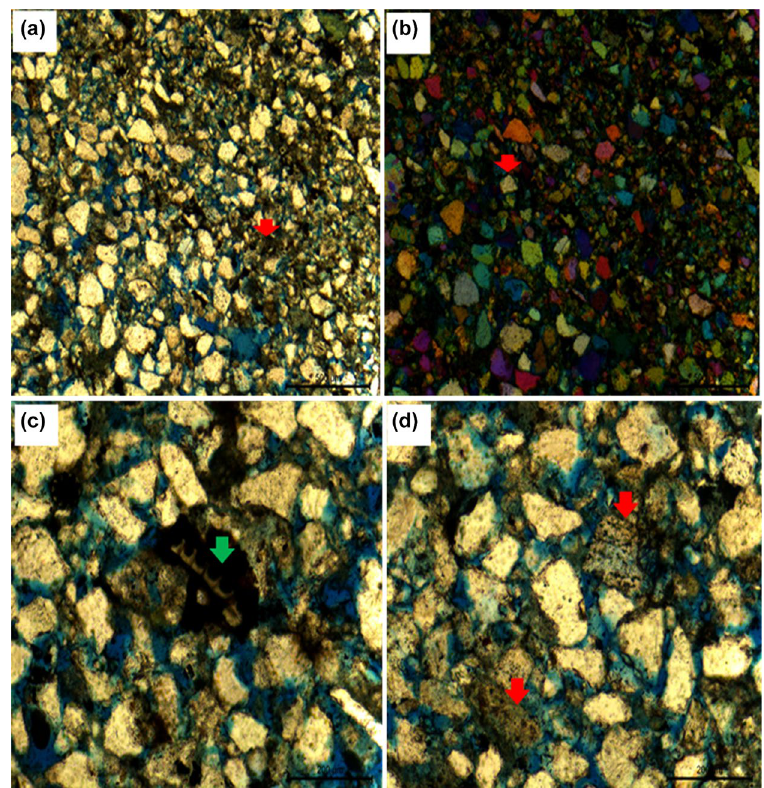
Fig. 8 Petrography of rock fabric variations: ( a ) fine- grained quartz mixed with rock fragments, ( b ) a XPL of calcite, FeO and siderite fraction, ( c ) shell fragment-intra-pore, ( d ) an altered K-feldspar grains in MFGS (WB5 C1B5) lithofacies sandstone at depth 1496.42